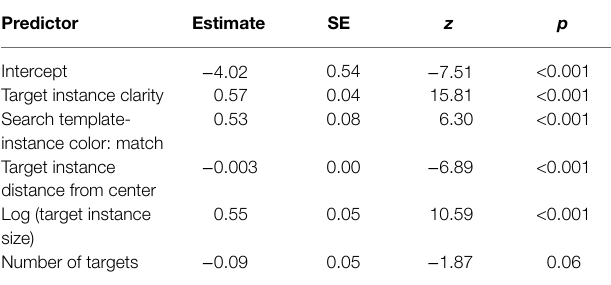
TABLE 5 | Multilevel logistic regression model predicting accuracy from target instance features, Experiment 2.